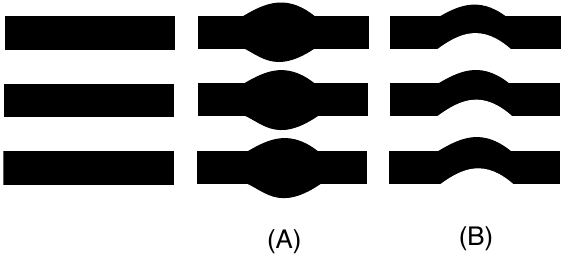
Figure 7 . The A and B modes respectively correspond to local squeezing/dilations and local